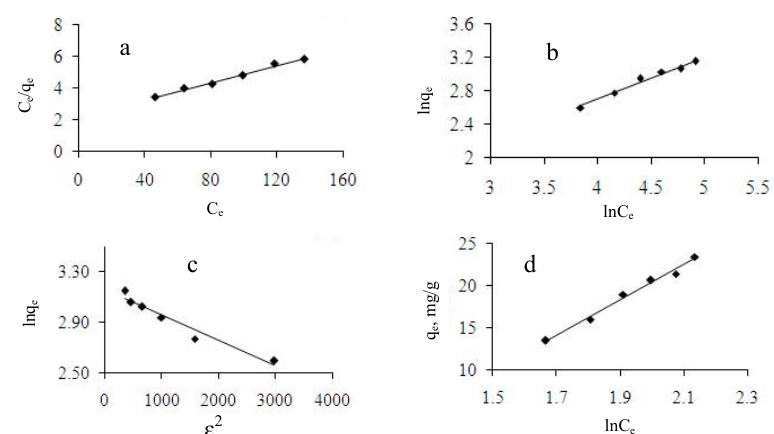
Figure 4. Adsorption isotherm plots for MG onto CSAC, (a) Langmuir plot, (b) Freundlich plot, (c) Dubinin-Raduskevich (D-R) plot, (d) Tempkin